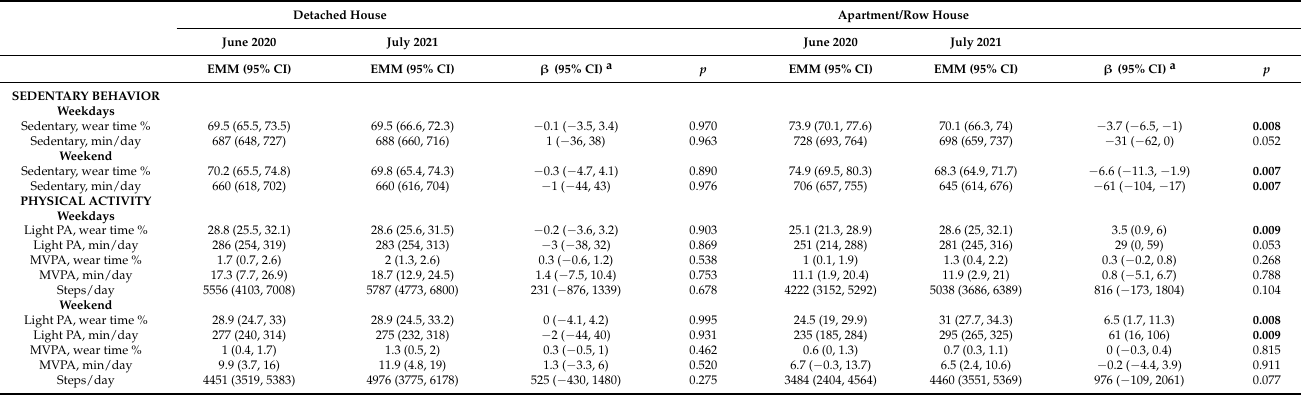
Table 2. Volumes of objectively measured physical activity and sedentary behavior before and after COVID-19 vaccination in older adults with hypertension according to the housing